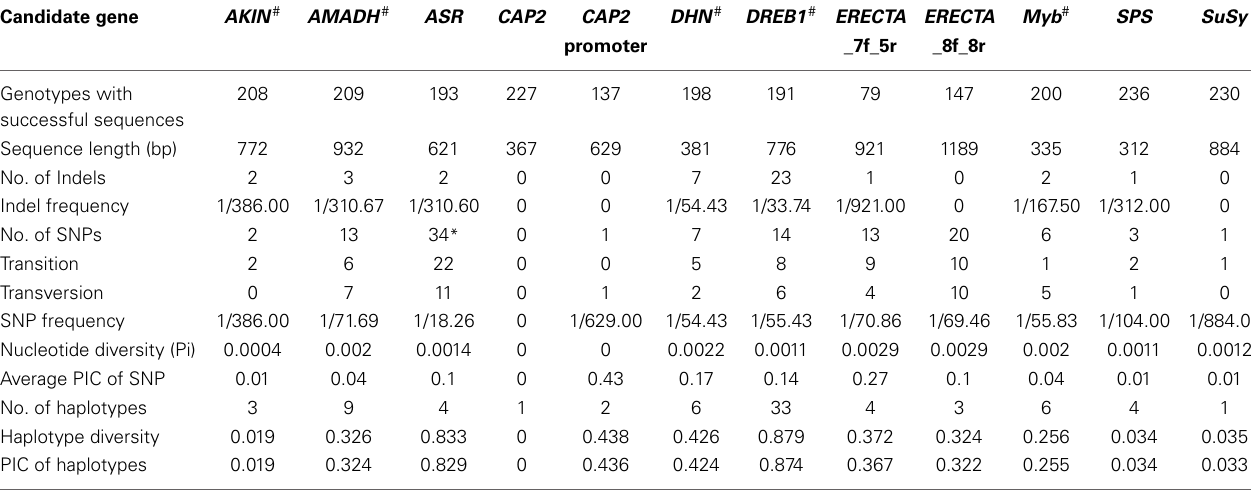
Table 3 | Estimation of sequence diversity in chickpea reference set/mini core collection using 10 abiotic stress responsive genes. Candidate